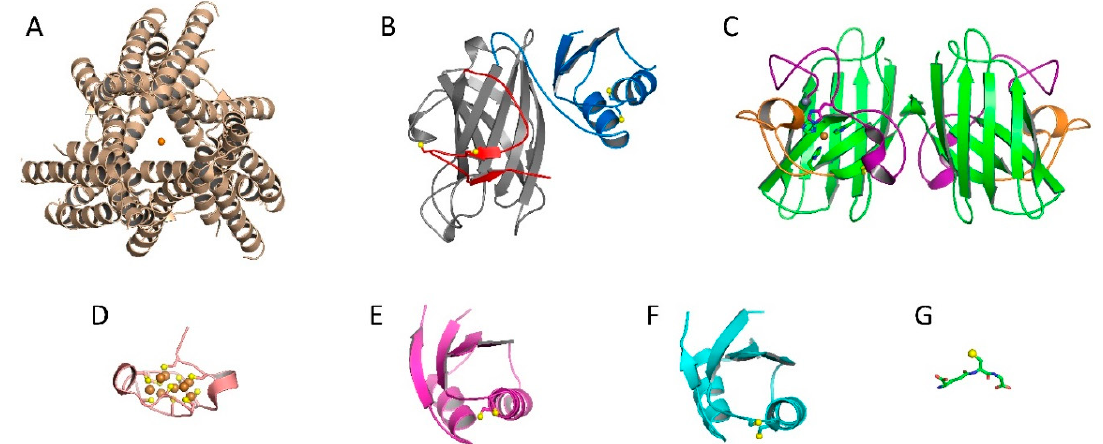
Figure 1. A collection of copper-binding molecules relevant to copper acquisition, regulation, and distribution to Sod1. ( A ) The copper importer Ctr1 with copper (orange sphere) bound in the channel (PDB: 6M98). ( B ) The structure of yeast Ccs, complete with D1 (blue), D2 (gray), and D3 (red). Copper binding cysteines are shown as yellow spheres (PDB: 5U9M). ( C ) Mature Sod1 dimer with the β -barrel shown in green and critical loop elements in purple (zinc loop) and orange (electrostatic loop). Active site bound copper is displayed as an orange sphere and the adjacent zinc shown in grey (PDB: 1PU0). ( D ) Copper bound MT3 domain with the coppers as orange spheres and the coordinating cysteines as yellow spheres (PDB: 1RJU). ( E ) The copper chaperone Atox1 (monomer) with the MTCxxC cysteines shown as yellow spheres (PDB: 5F0W). ( F ) A copper-binding domain (repeat 2) of the transport protein ATP7B, again with the conserved MTCxxC cysteines shown as yellow spheres (PDB: 2LQB). Notice the structural similarities between Ccs D1, Atox1, and ATP7B. ( G ) The structure of the glutathione tri-peptide, with the cysteine shown as a yellow sphere (PDB: 1AQW).